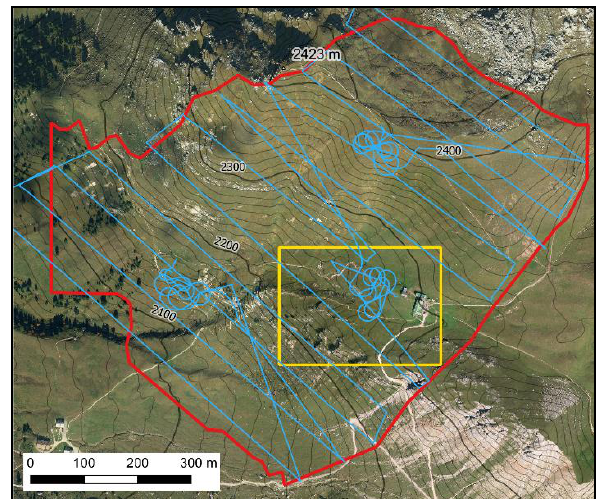
Figure 1. Test site Zendleser Kofel (South Tyrol, Italy) showing the ULS data coverage (red), the flight trajectories from 2019 (blue) and the rectangular test site subset (yellow). Orthophoto and contours: Autonomous Province of Bozen - South